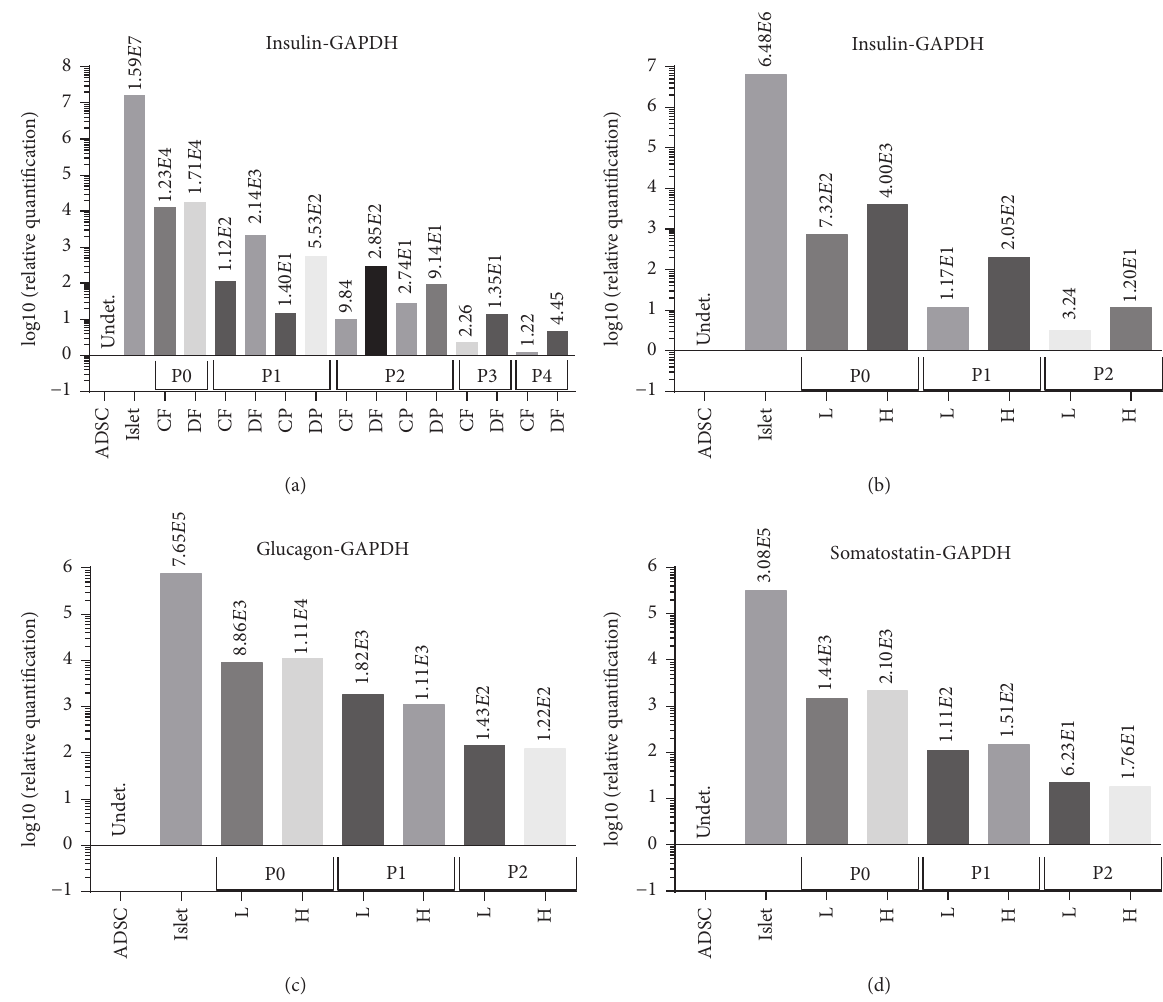
Figure 3: Expression of pancreatic endocrine genes in islet-derived cells cultured with different media. Analysis of gene expression (mRNA) using qRT-PCR was performed on cells isolated from different pigs and representative results are presented. (a) Islet-derived cells were cultured in CMRL media containing 10% FBS (CF) or 20% PS (CP) and in DMEM media containing 10% FBS (DF) or 20% PS (DP) and analyzed for the expression of insulin mRNA. (b–d) Islet-derived cells were cultured in DMEM media containing 10% FBS and 1g/L (L) or 4.5 g/L (H) glucose and analyzed for the expression of insulin (b), glucagon (c), and somatostatin (d) mRNA. The results are the average fold increase for each indicated mRNA compared with the level of this mRNA in adipose-derived stem cells (ADSC) and normalized for the expression of